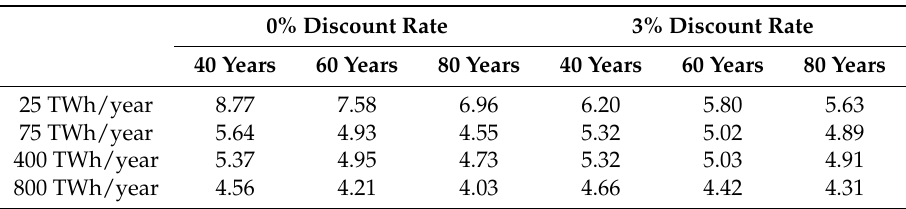
Table 3. LCOE for AFC in different scenarios in $(2010)/MWh.